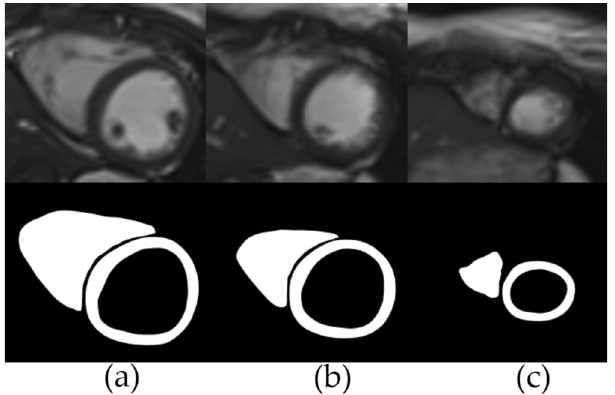
Figure 10. Shows the segmentations obtained via Segment software respectively for the ( a ) basal ( b ) mid- ventricular ( c ) apical